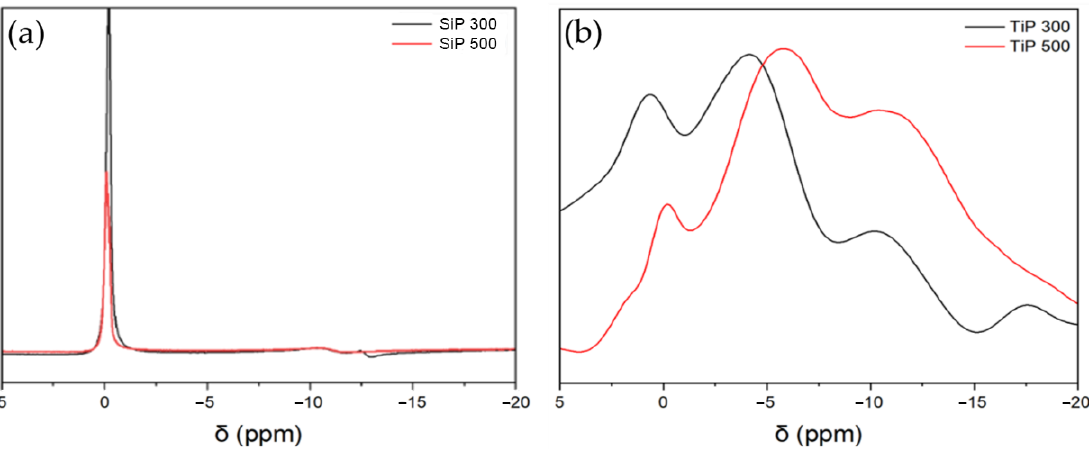
Figure 3. 31 P MAS NMR spectra of the phosphated ( a ) silica and ( b ) titania